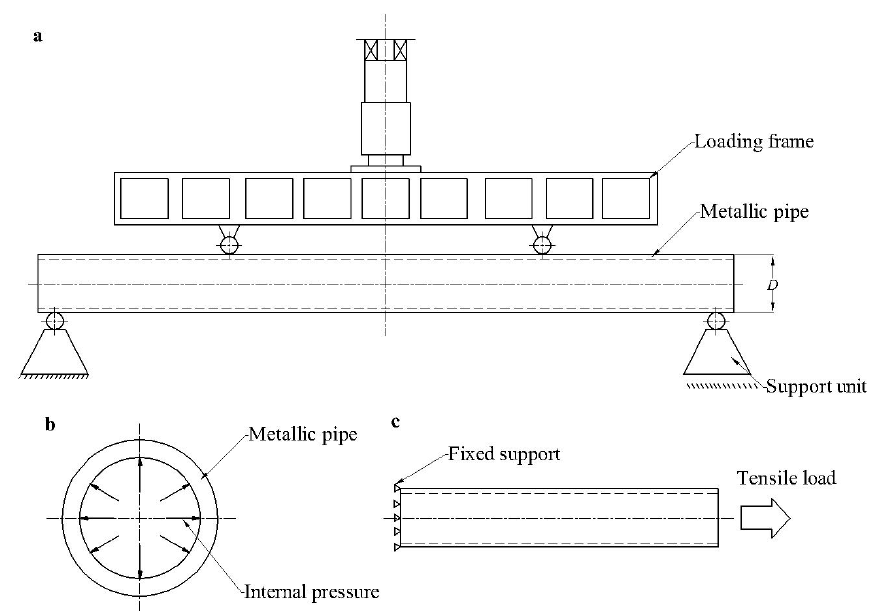
Figure 7. Test set-up and load cases: ( a ) 4-point bending, ( b ) internal pressure, and ( c ) tension.